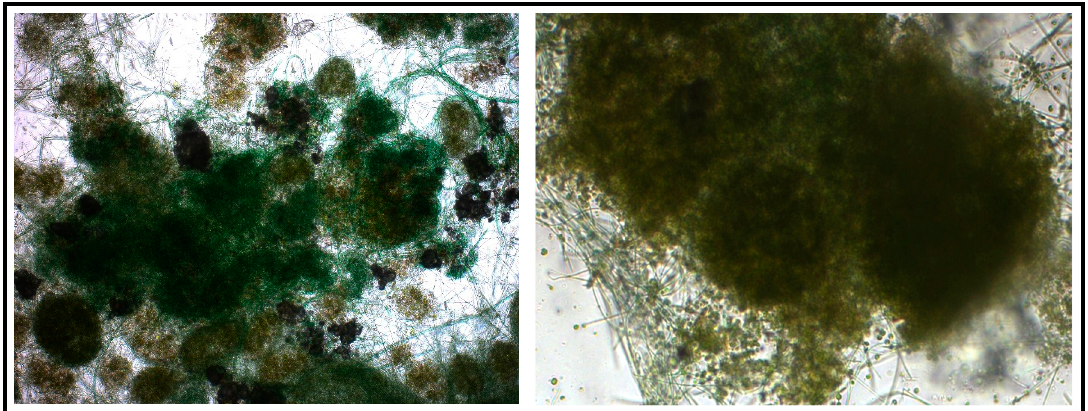
Figure 10. Characteristic views with microscopic magnification ×100 of the evolving M-BGS after 45 days of H-PBR.